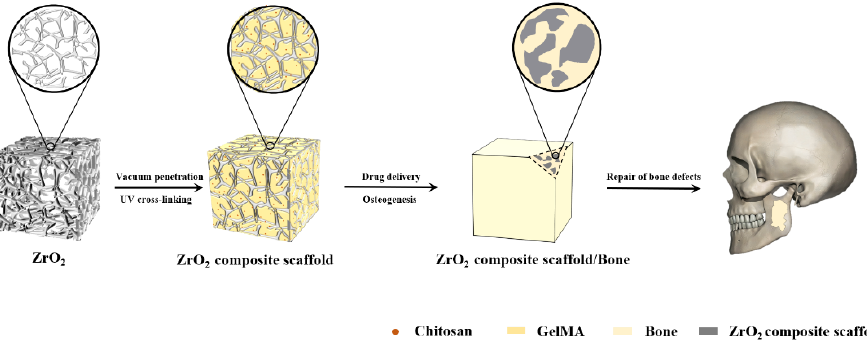
Figure 10. Schematic functions of the ZrO 2 – chitosan particles – GelMA composite scaffold. In the experiment to prepare porous zirconia matrixes, 0.1 wt% PVA was added into the slurry of 70 wt% Y-TZP powder and 30 wt% deionized water. PVA is a viscous agent, which can improve the viscosity of the slurry. As a result, the slurry can be firmly stuck to the polyurethane sponge blocks, maintaining the integrity of the zirconia matrixes.